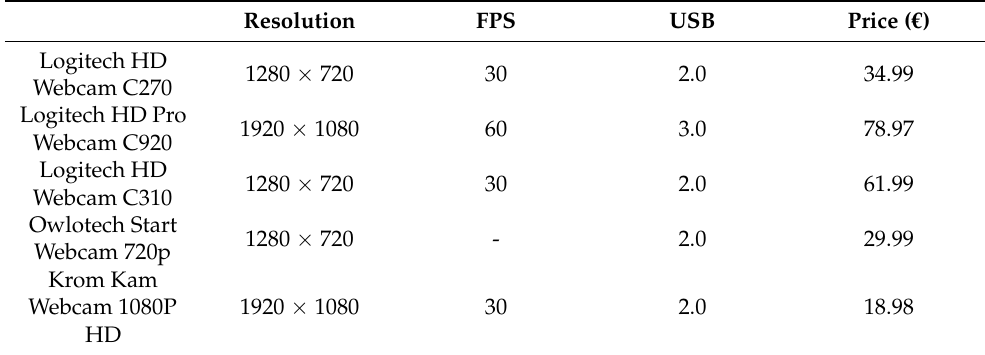
Table 1. Comparison of RGB cameras (prices last updated in March